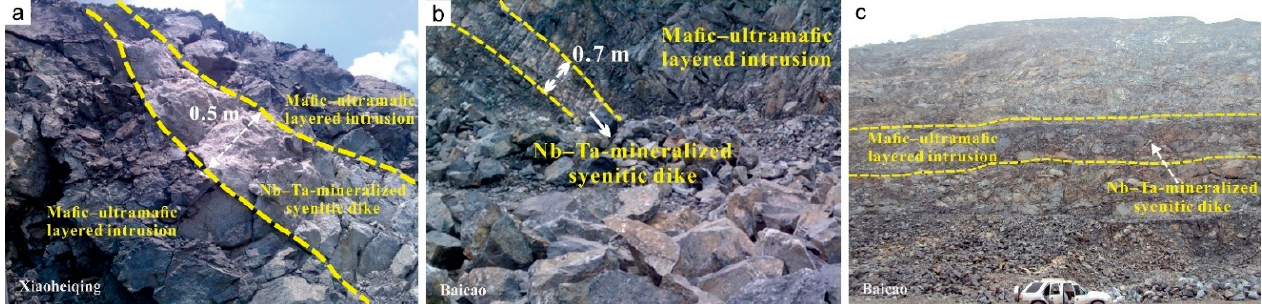
Figure 4. Field photos of the gray and white Nb–Ta mineralized syenitic dikes intruding the deep gray mafic–ultramafic layered intrusions: ( a ) sample point in Xiaoheiqing deposit (26°42’53.69”N, 102°0’35.33”E); ( b ) sample point in Baicao deposit (26°41’19.43’’N, 102°0’28.46’’E); and ( c ) large outcrop in Baicao deposit showing obvious layered intrusions and massive dike intrusions.